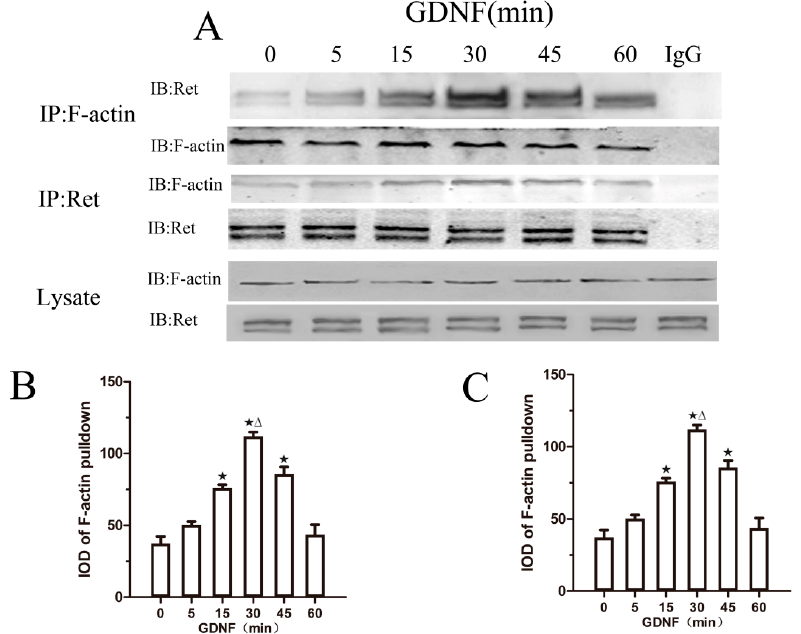
Figure 3. GDNF induces Ret–F-actin association in cultured MN9D cells. ( A ) Lysates obtained from MN9D cells, which were stimulated with GDNF for the indicated durations, were immunoprecipitated (IP) with anti-F-actin, anti-Ret, or normal rabbit IgG (IgG IP). As a loading control, the amount of F-actin and Ret present in the whole lysates is shown at the bottom; ( B ) Quantitative analysis of integrated optical density (IOD) of immunoprecipitated Ret from the experiments are depicted in ( B ); ( C ) Quantitative analysis of IOD of immunoprecipitated F-actin from the experiments are depicted in ( C ). Data were presented as the mean ± SEM of three independent experiments. ★ p < 0.05 vs. 0 min, ∆ p < 0.05 vs. 15 min.